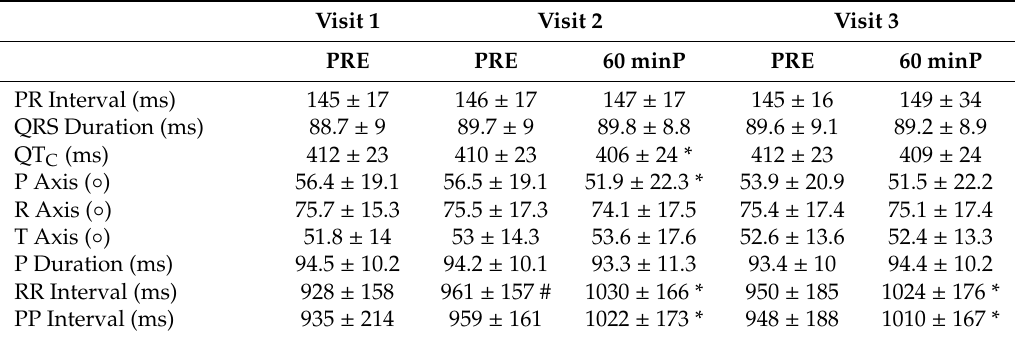
Figure 2. Collapsed data ( n = 125; group and sex) for group changes in ( A ) heart rate and ( B ) blood pressure (systolic (toward the top) and diastolic (toward the bottom)). * Significantly ( p < 0.05) different from respective visit’s PRE; # Different ( p < 0.10) from Visit 1 (V1) ; minP = minutes post PRE; mmHg = millimeters of mercury; bpm = beats per minute. Table 2. Collapsed ( n = 125; group and sex) data for group changes in electrocardiogram measures. n = 25 participants per group.